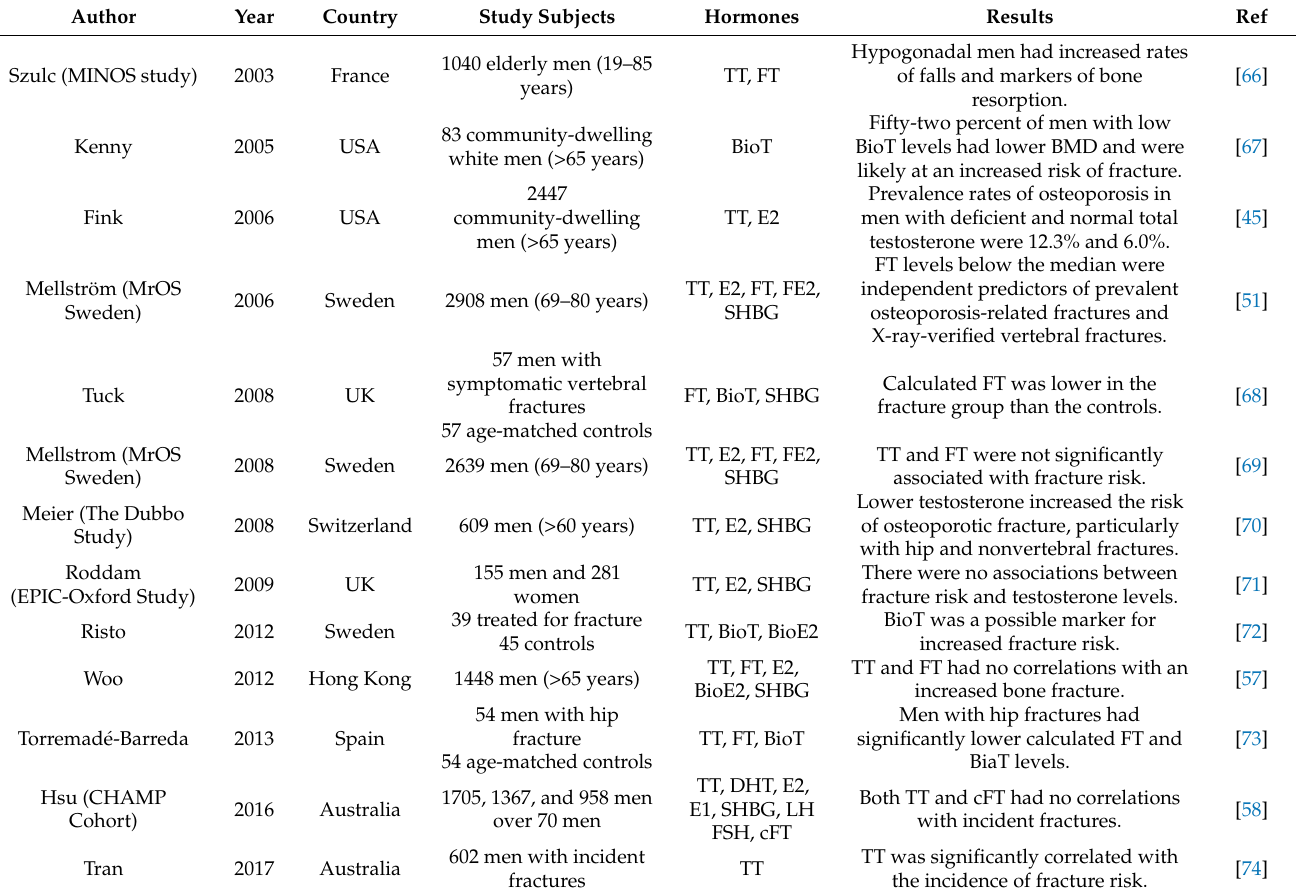
Table 3. The relationship between testosterone and bone fractures